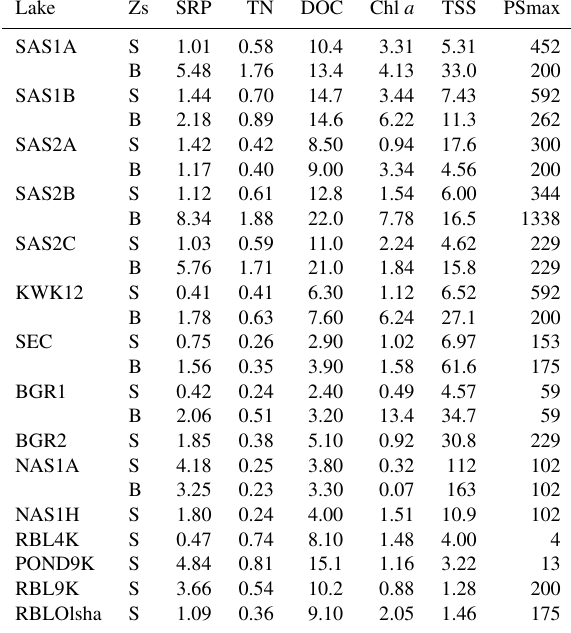
Table 3. Limnological properties of study sites. Zs, sample depth, soluble reactive phosphorus (SRP, in µgL − 1 ) , total nitrogen (TN, in mgL − 1 ) , dissolved organic carbon (DOC, inmgL − 1 ) , Chloro- phyll a (Chl a , in µgL − 1 ) , total suspended solids (TSS, inmgL − 1 ) ; PS max , maximum frequency of particle size distribution (µm). The S samples correspond to surface at 0m, and the B samples corre- spond to the maximum depth of each lake.